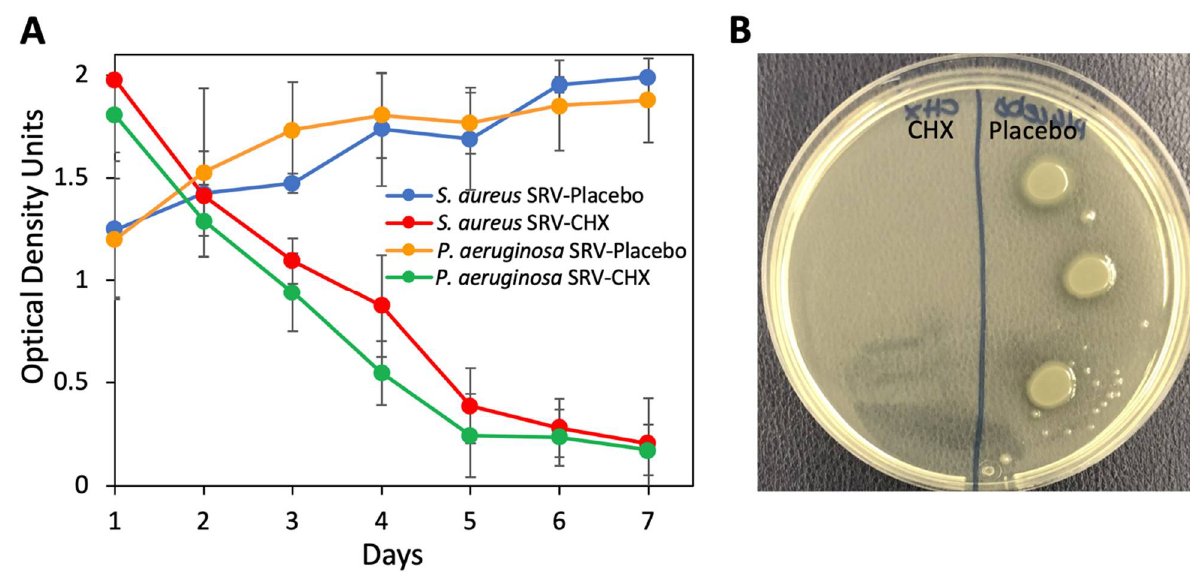
Figure 3. ( A ) SRV-CHX- and SRV-placebo-coated stents were incubated daily with planktonic growing bacteria, and the OD was measured after 24 h. n = 3. p < 0.05 SRV-CHX-coated stents versus SRV-placebo-coated stents. ( B ) Three drops of 10 µL of each sample at day 1 were seeded on agar plates followed by a 24 h incubation.